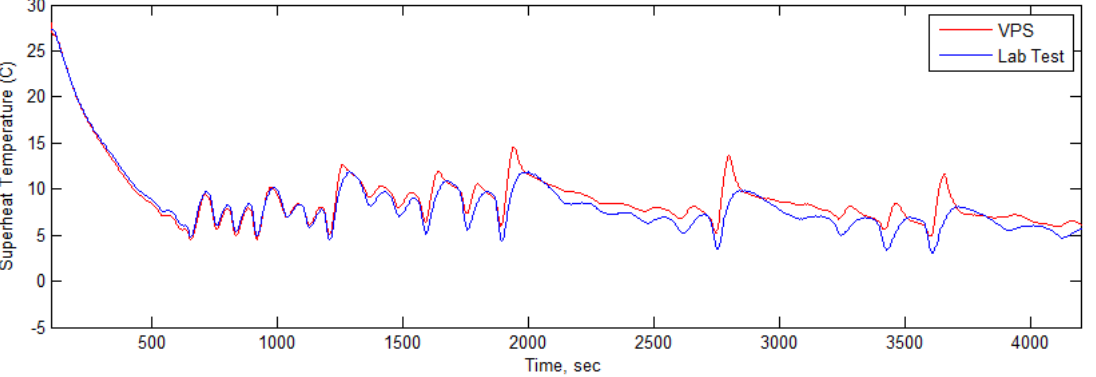
Figure 4. Test Case 1—superheat temperature estimation: Virtual Pressure Sensor (VPS vs. test.